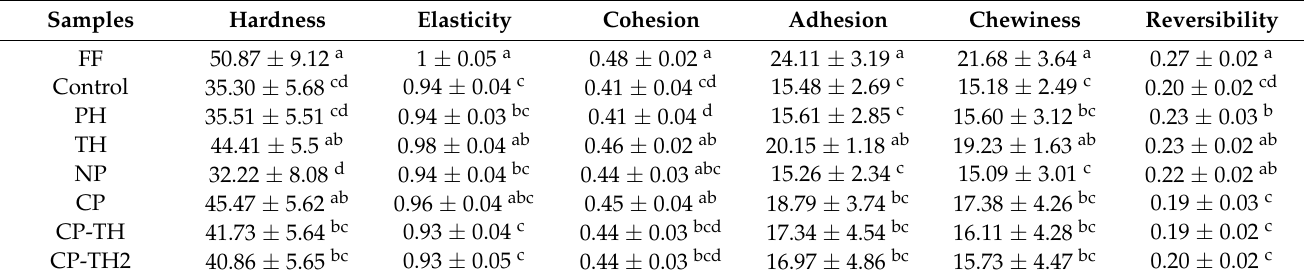
Table 2. Effects of different treatments on the texture properties of fish nuggets induced by freeze- thaw